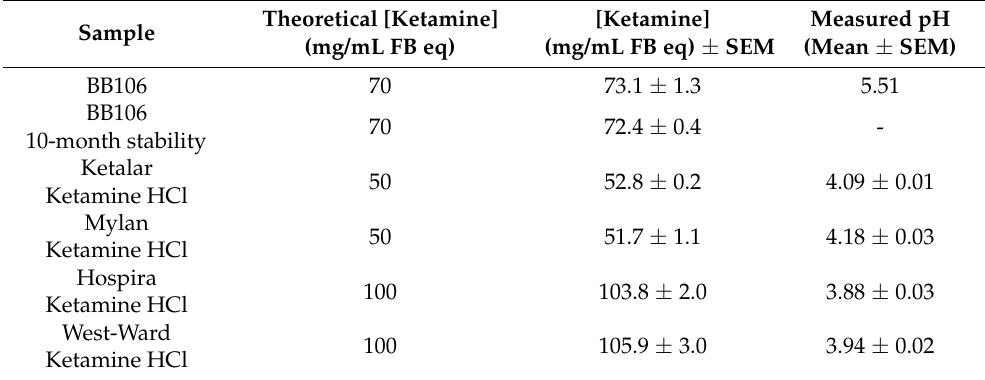
Table 2. Concentration of Ketamine in BB106 and commercial Ketamine HCl samples. Commercial ketamine HCl samples (Ketalar, Mylan, Hospira, and West-Ward) were sampled from two separate bottles, each measured in triplicate.